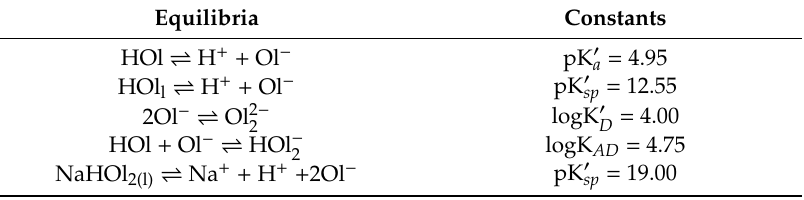
Table 2. Equilibrium constants for oleate species in aqueous solution [29] (total ionic concentration = 1 × 10 − 2 mol/L).